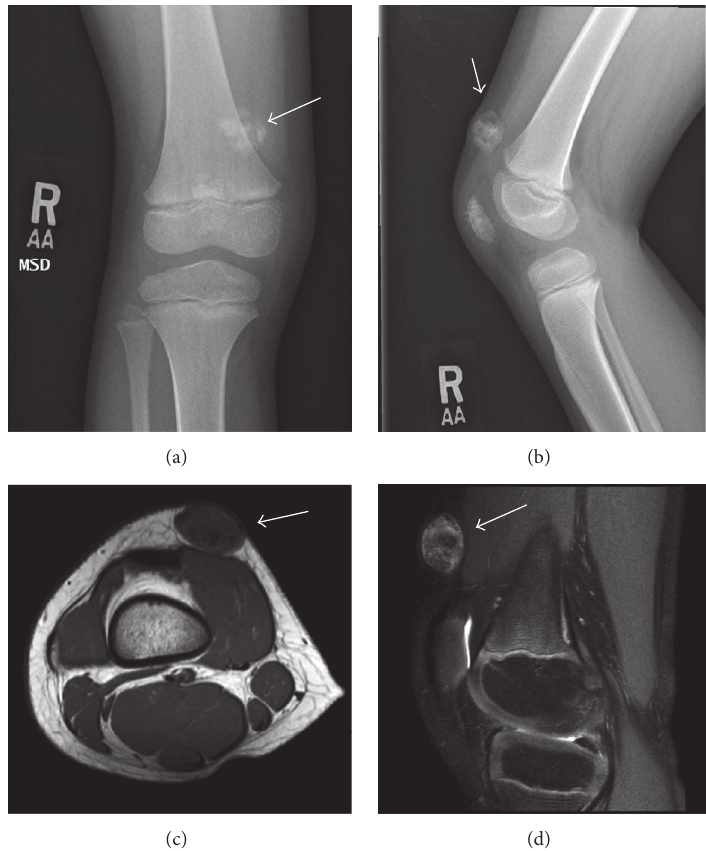
Figure 1: AP (a) and lateral (b) radiographic imaging of distal femur demonstrates aberrant calcification of the suprapatellar region within the soft tissue. Transverse (c) and lateral magnetic resonance imaging (d) reveals that the calcified mass is confined to the subcutaneous tissue with no connections to the underlying bone.